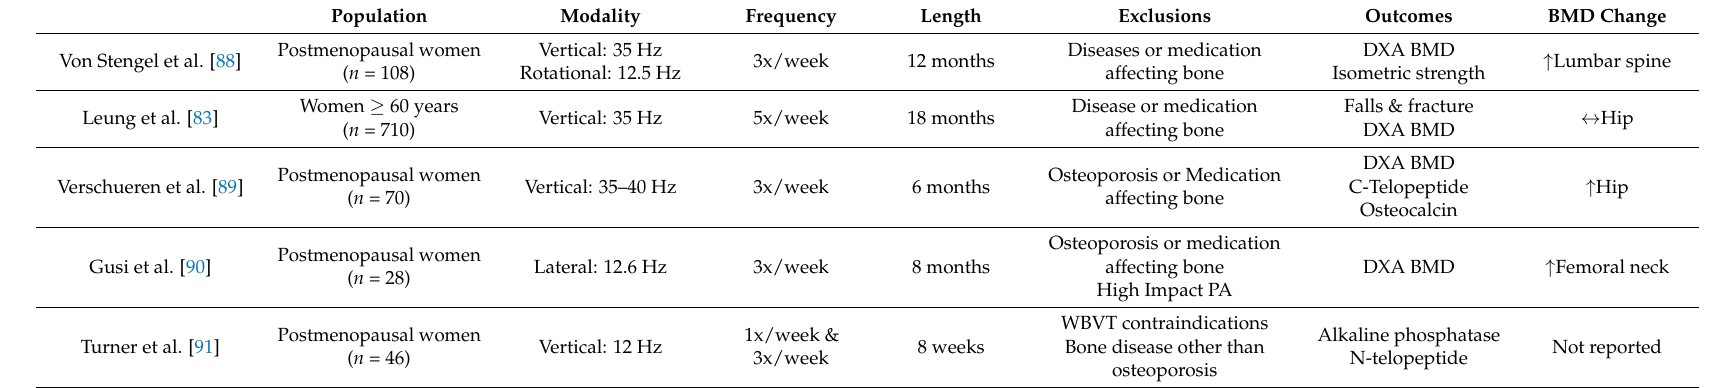
Table 2. Summary of selected Whole Body Vibration Training studies in post-menopausal